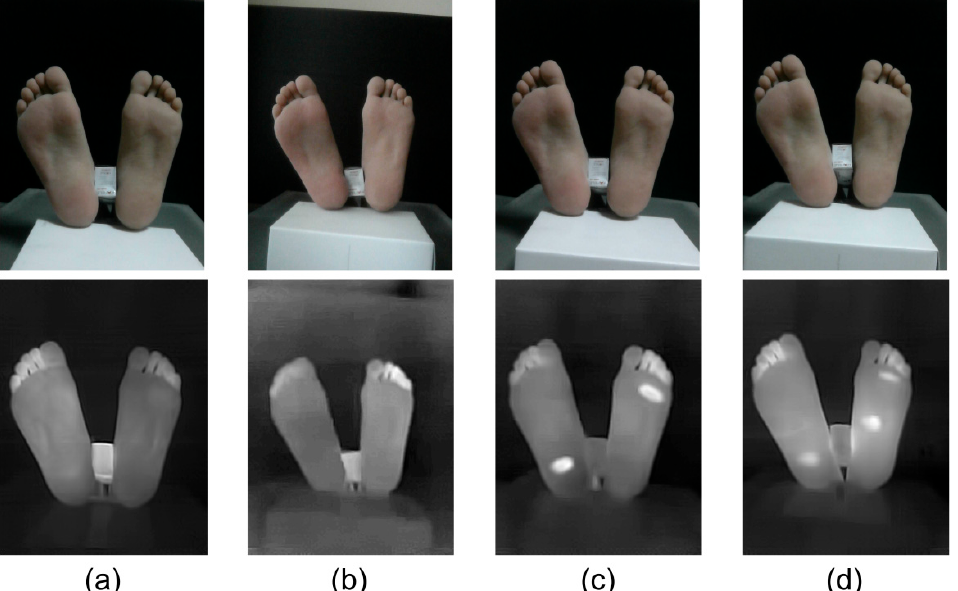
Figure 2. Images from Phantom Feet data set: ( a ) without inflammation (no regions of thermal difference between the left and right foot); ( b ) inflammation in toes’ area of left foot; ( c , d ) multiple inflammation regions.